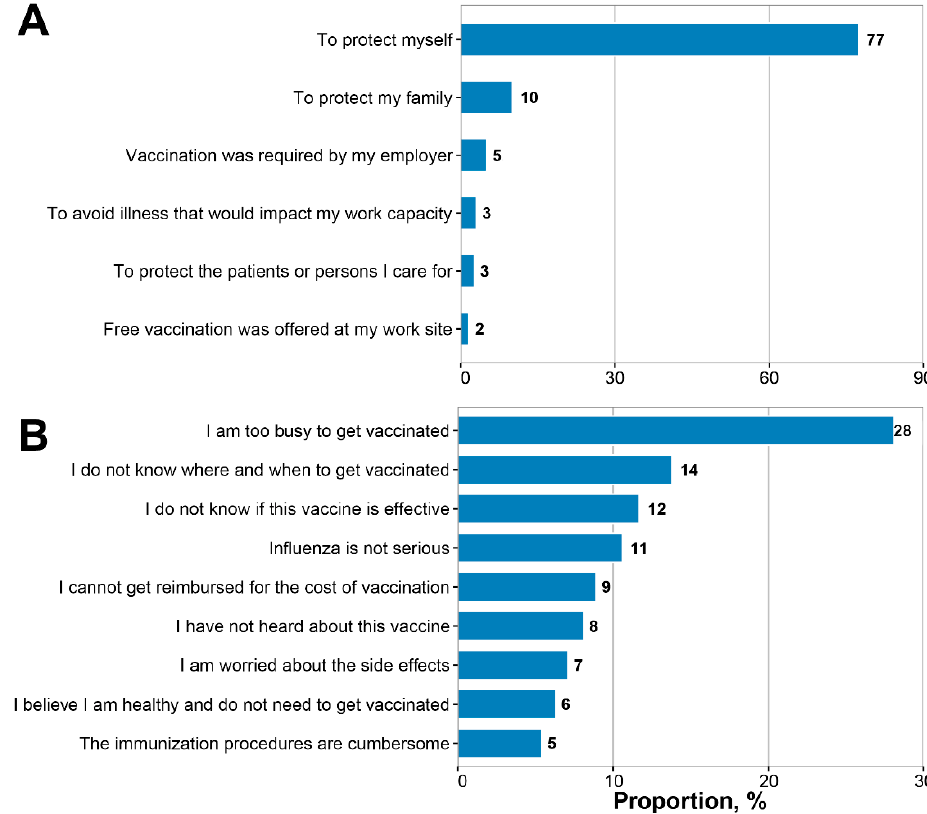
Figure 1. Reasons for receiving or not receiving the influenza vaccine among registered nurses, China, 2017 / 2018. ( A ) Main reason for receiving the influenza vaccine among 257 vaccinated nurses; ( B ) main reason for not receiving the influenza vaccine among 3896 unvaccinated nurses.